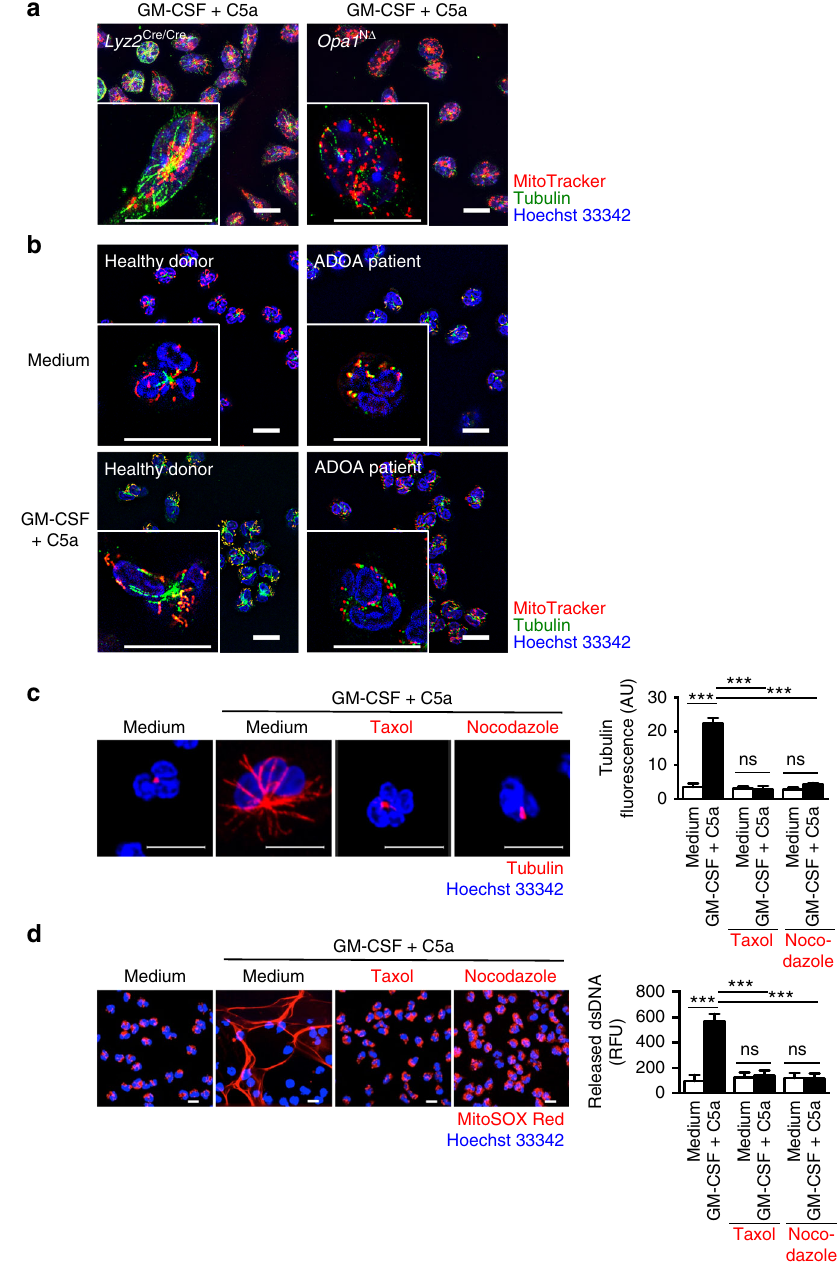
Fig. 2 Absence of microtubule formation in OPA1-de fi cient human and mouse neutrophils. a Super-resolution microscopy. Microtubule formation and mitochondrial morphology of primary mature neutrophils from Opa1 N Δ and control mice following GM-CSF priming and subsequent C5a stimulation. Microtubules were stained with anti- α -tubulin antibody (green), the nucleus with Hoechst 33342 (blue) and mitochondria with MitoTracker ® Orange (red). Images were acquired by ELYRA super-resolution microscopy. Bars, 10 µ m. The data are representative of three independent experiments. Quanti fi cation and additional data including microtubule formation induced by other triggers are provided in Supplementary Fig. 4a – c. b Super-resolution microscopy. Microtubule formation and mitochondrial morphology in human blood neutrophils from control individuals and an ADAO patient (son, see Fig. 1) following GM-CSF priming and subsequent C5a stimulation. Microtubules were stained with anti- α -tubulin antibody (green), the nucleus with Hoechst 33342 (blue) and mitochondria with MitoTracker ® Orange (red). Single cells are shown at higher magni fi cation in the insets. Images were acquired by ELYRA super-resolution microscopy. Bars, 10 µ m. The data are representative of three independent experiments. Quanti fi cation is provided in Supplementary Fig. 5a. c Confocal microscopy. Microtubule assembly was analyzed in human control neutrophils following pre-treatment with the indicated inhibitors and subsequent combined GM-CSF/C5a stimulation. Microtubules were stained with anti- α -tubulin antibody (red), the nucleus with Hoechst 33342 (blue). Bars, 10 µ m. Right: Quanti fi cation of the microtubule network formation was performed by automated analysis of microscopy images using Imaris software. Values are means ± SEM. n.s., not signi fi cant; *** p < 0.001; n = 5. d Confocal microscopy. Human blood neutrophils from control individuals pretreated with the indicated inhibitors were stimulated with GM-CSF/C5a. Extracellular DNA was stained with MitoSOX ™ Red and the nucleus with Hoechst 33342 (blue). Bars, 10 μ m. Right: quanti fi cation of the released dsDNA in supernatants of activated neutrophils. Values are means ± SEM. n.s., not signi fi cant; *** p < 0.001; n =